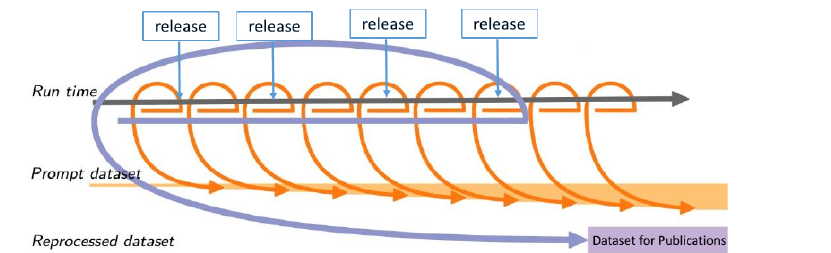
Figure 5. The rough scheme of prompt processing vs. major reprocessing. Releases are basf2 soft- ware versions, the prompt dataset will contain data reprocessed from several basf2 versions. A new reprocessed dataset is made approximately every 6 months using old + new data and the best calibration constants available.